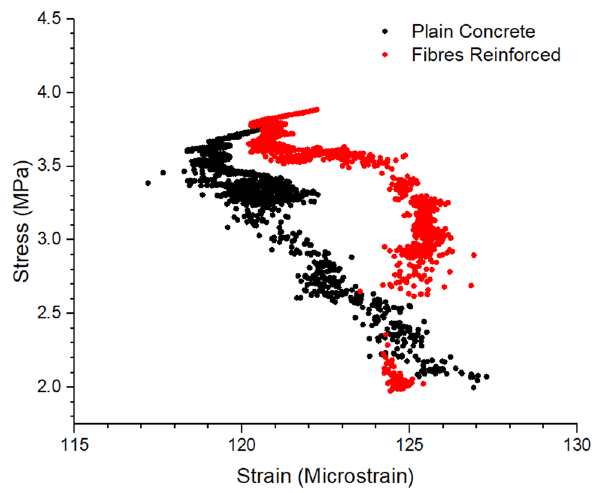
Figure 9. Typical stress–strain curves of plain concrete (200,200 cycles fatigue life) and fibre reinforced concrete (624,100 cycles fatigue life).